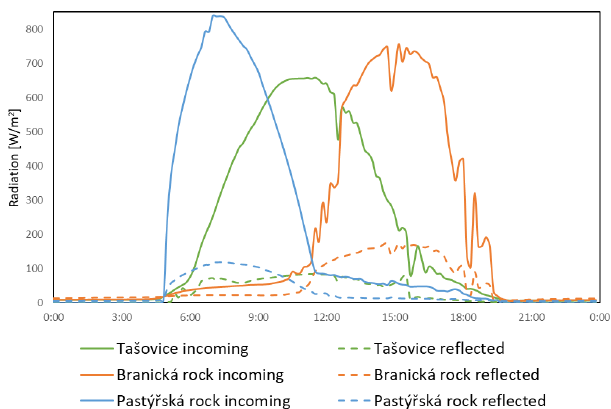
Figure 5. Example of the incoming and reflected radiation mea- sured by the pyranometers at the Branická, Tašovice, and Pastýˇrská rock sites. A 24h time series of incoming and reflected radiation is displayed. Data were recorded on 1 August 2020 with no clouds. The influence of the slope aspect is obvious from the incoming ra- diation peak